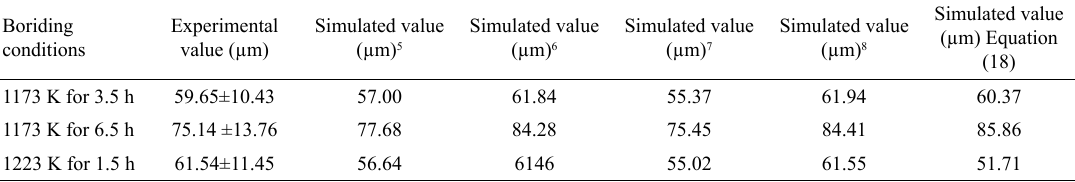
B phase equal to 9 wt.%. 2